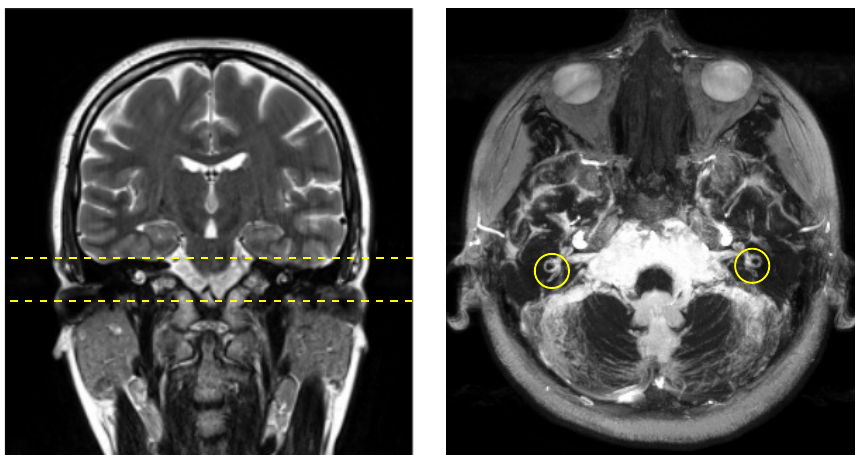
Figure 1. Subject imaging acquisition example: ( left ) volunteer coronal FSE localizer. Dashed straight yellow lines delimit the slab where the CISS-3D sequence was applied; and ( right ) cumulative projection of the CISS-3D sequence that includes the vestibular system, where semicircular ducts can be easily detected. The yellow circumferences denote the region where our study was